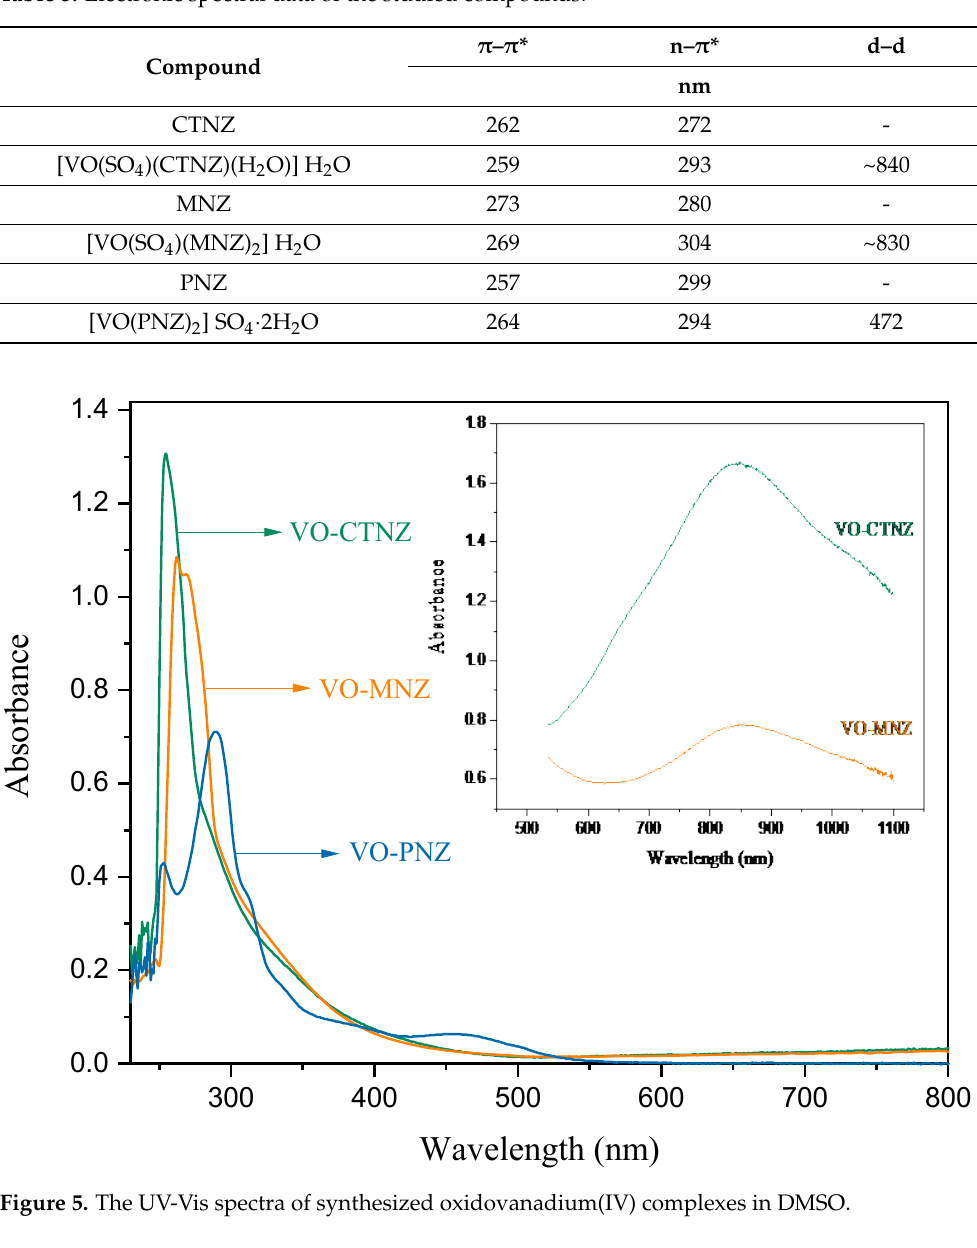
Table 5 . Electronic spectral data of the studied compounds.